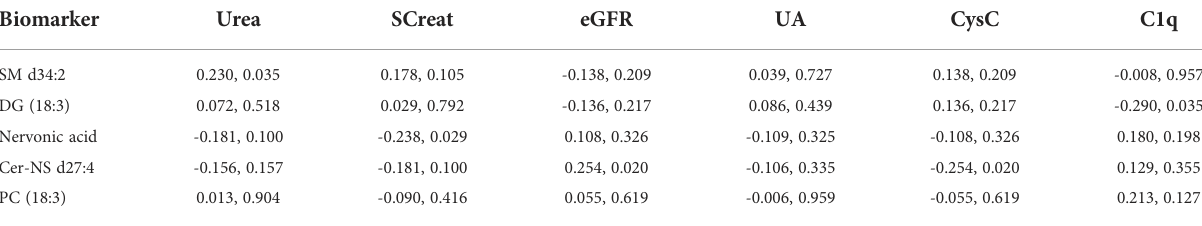
TABLE 6 Correlation analysis of differential metabolites and kidney function indicators ( r , P ).